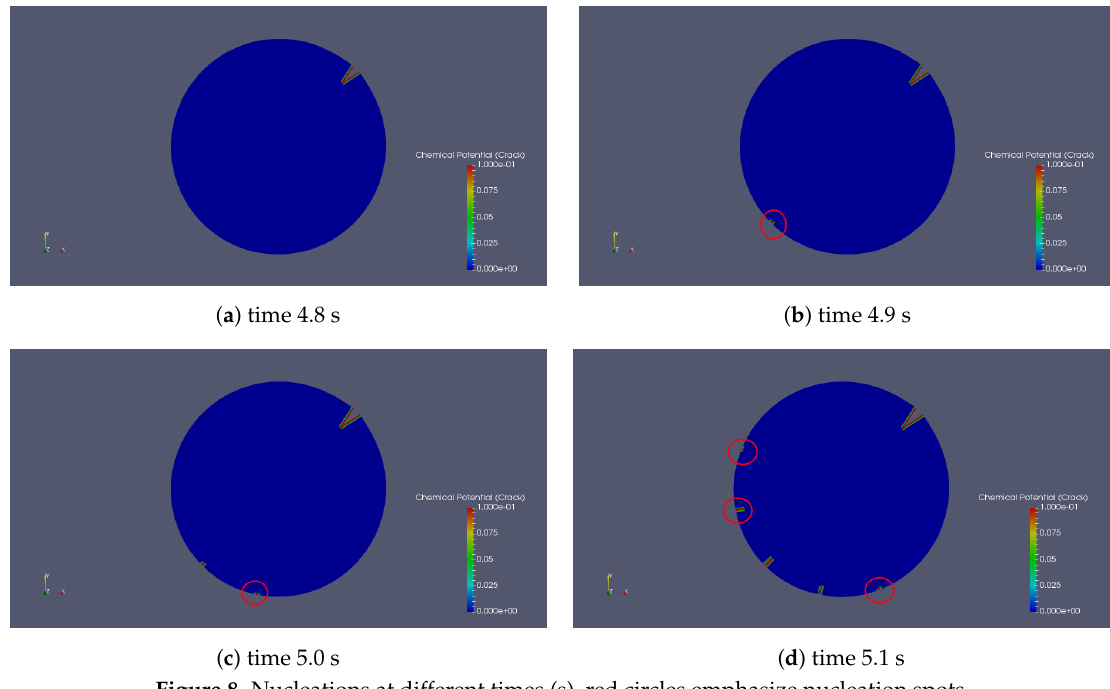
Figure 8. Nucleations at different times (s), red circles emphasize nucleation